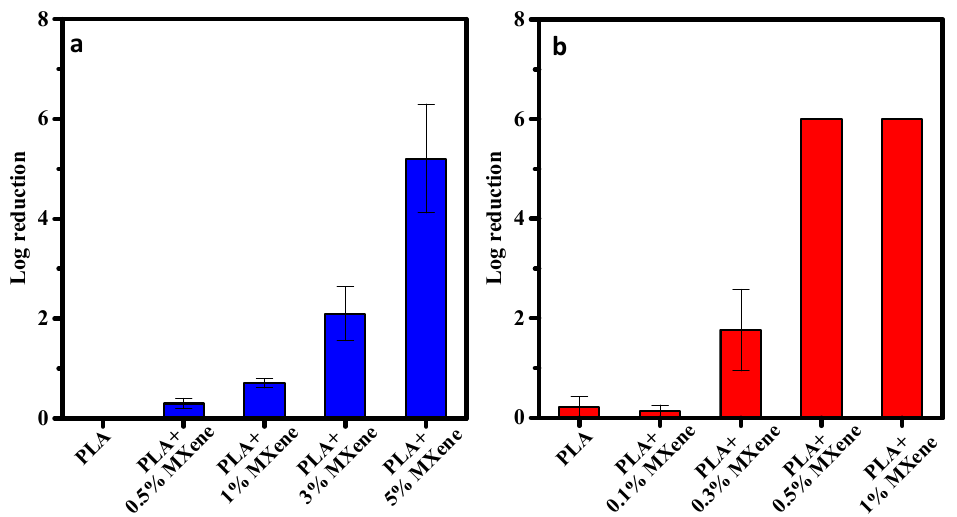
Figure 7. Logarithmic reduction for the PLA and the composite films with different concentrations of MXene ( a ) Salmonella enterica and, ( b ) Listeria monocytogenes .